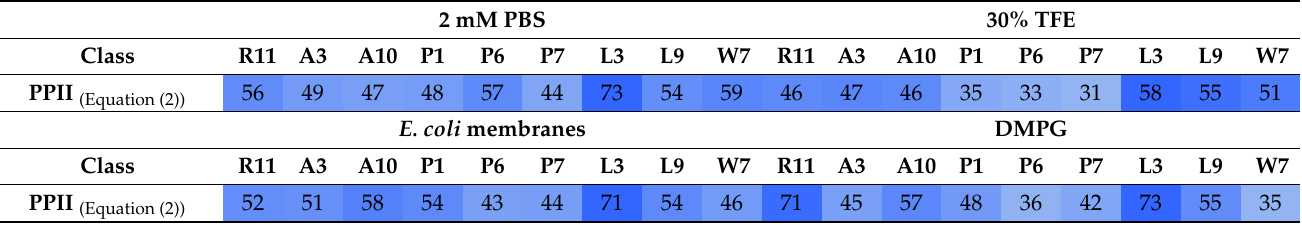
Table 2. Percentage of polyproline II secondary structure calculated according to Equation (2) for the peptides with best MBC presented in Table 1. Values are shaded in blue from light to dark for low-to-high values.